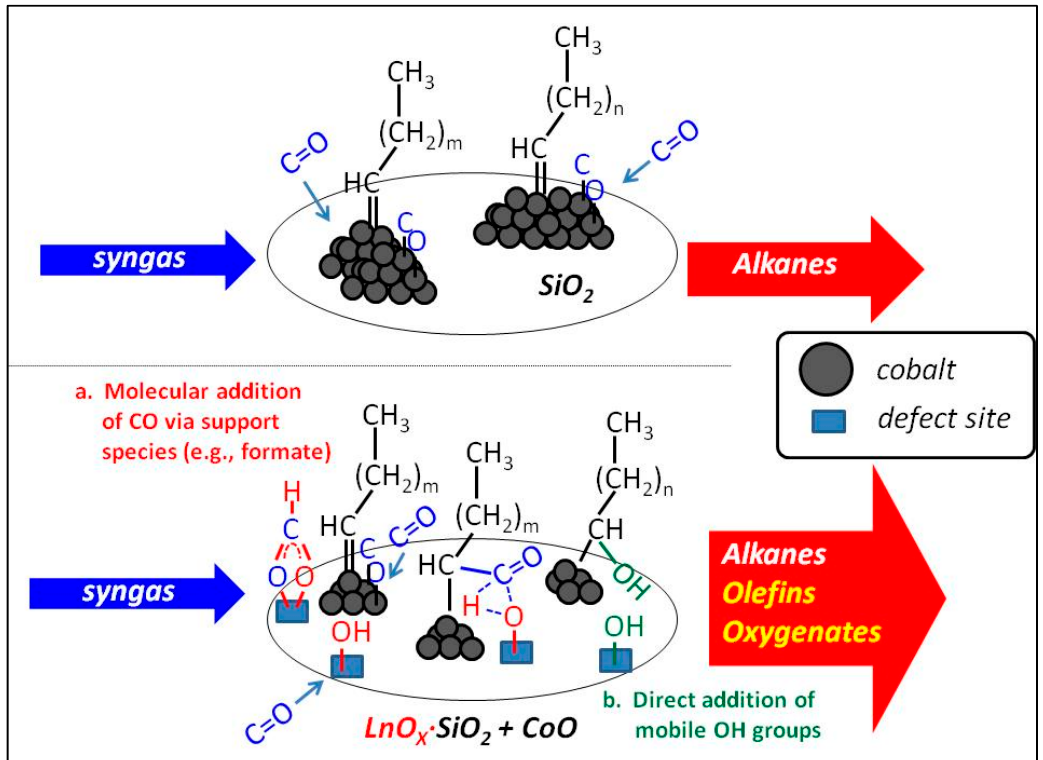
Figure 33. A mechanistic display of CO molecular addition through defect sites.